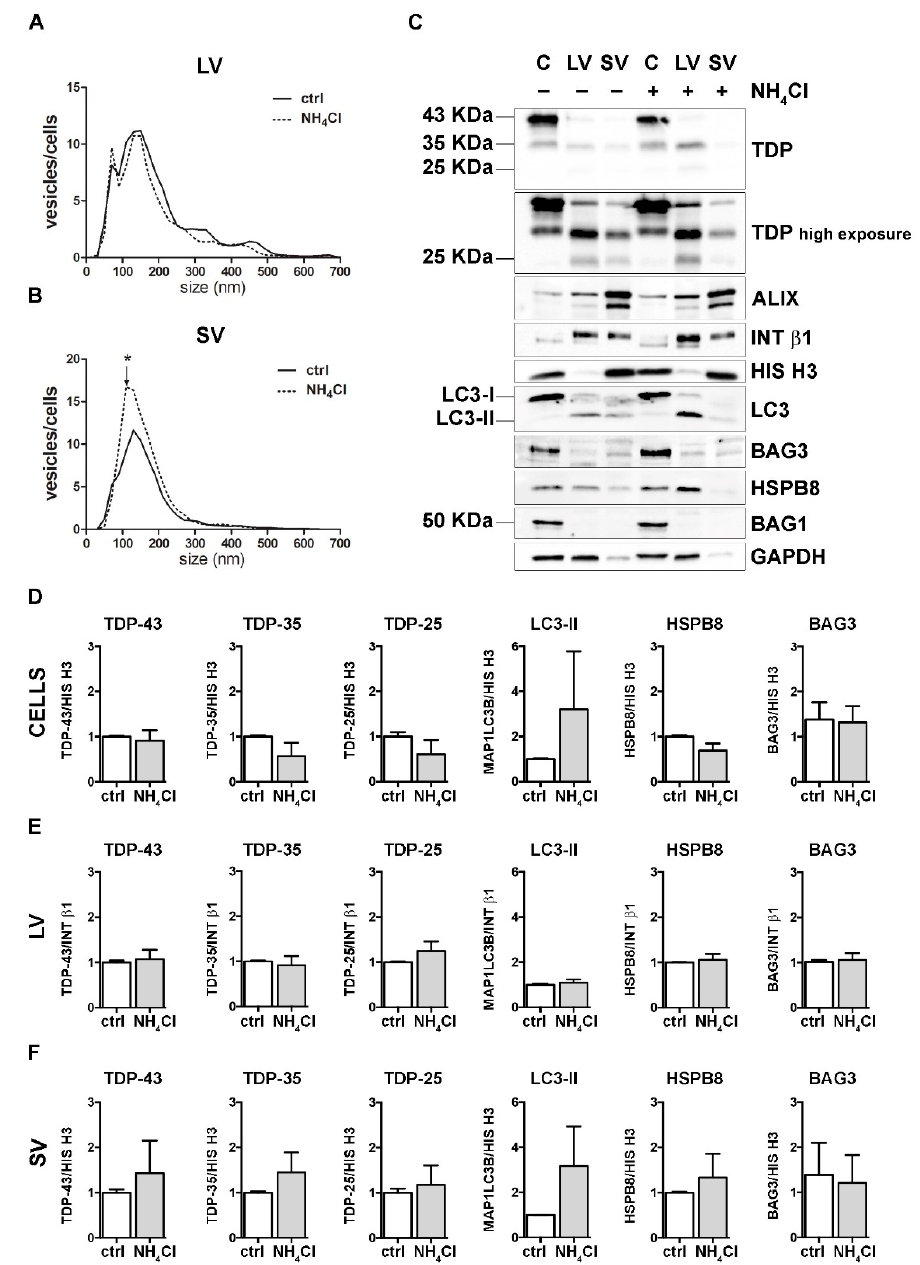
Figure 4. Autophagy inhibition and the modulation of EVs number and protein content. ( A , B ) NTA distribution of LVs ( A ) and SVs ( B ) isolated from NSC-34 cells treated o/n with NH 4 Cl (20 mM). The graphs represent the mean of n = 3 biological replicates; x -axis = vesicles dimension, expressed in nm; y -axis = vesicles concentration, expressed as ratio between the number of vesicles and the number of secreting cells. The data show that NH 4 Cl treatment statistically increased the secretion of 110 nm small vesicles ( B ) (* p < 0.05, Welch’s t -test). ( C – F ) WB analysis ( C ) and relative quantifications ( D – F ) of total RIPA-extracted proteins from NSC-34 cells, LVs and SVs, untreated or treated o/n with NH 4 Cl (20 mM). Samples were analyzed for TDP-43 species, MAP1LC3B-II, BAG3, HSPB8, BAG1, ALIX, INT β 1 and HIS H3. Bar graphs represent the mean optical density ± SD of a specific protein normalized on the optical density of the internal housekeeping protein (HIS H3 for cells and SVs; Int β 1 for LVs) and reported in comparison to the corresponding untreated sample (ctrl), of three biological replicates.